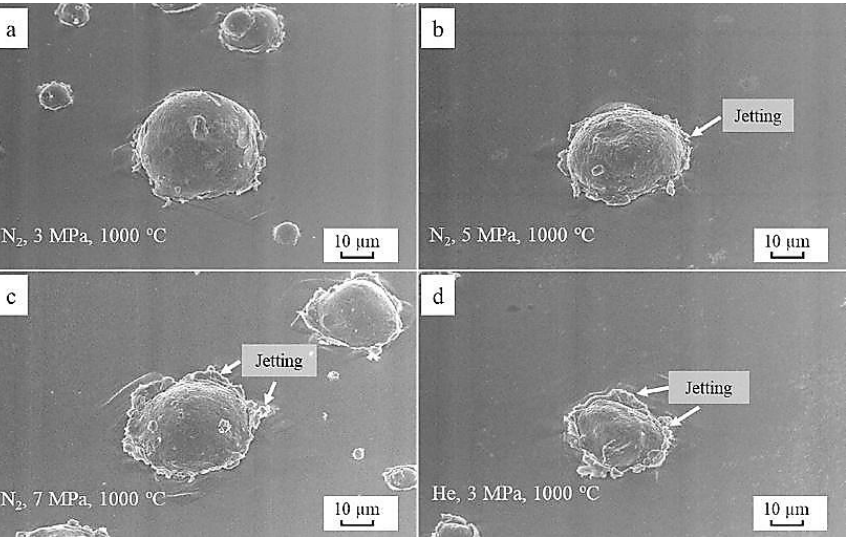
Figure 7. The morphology of a single splat of IN 718 on the substrate deposited using a constant temperature at 1000 °C and nitrogen at ( a ) 3 MPa, ( b ) 5 MPa, and ( c ) 7 MPa, as well as ( d ) He at 3 MPa. Reprinted from Ma et al. [78], Copyright 2019, with permission from Elsevier.